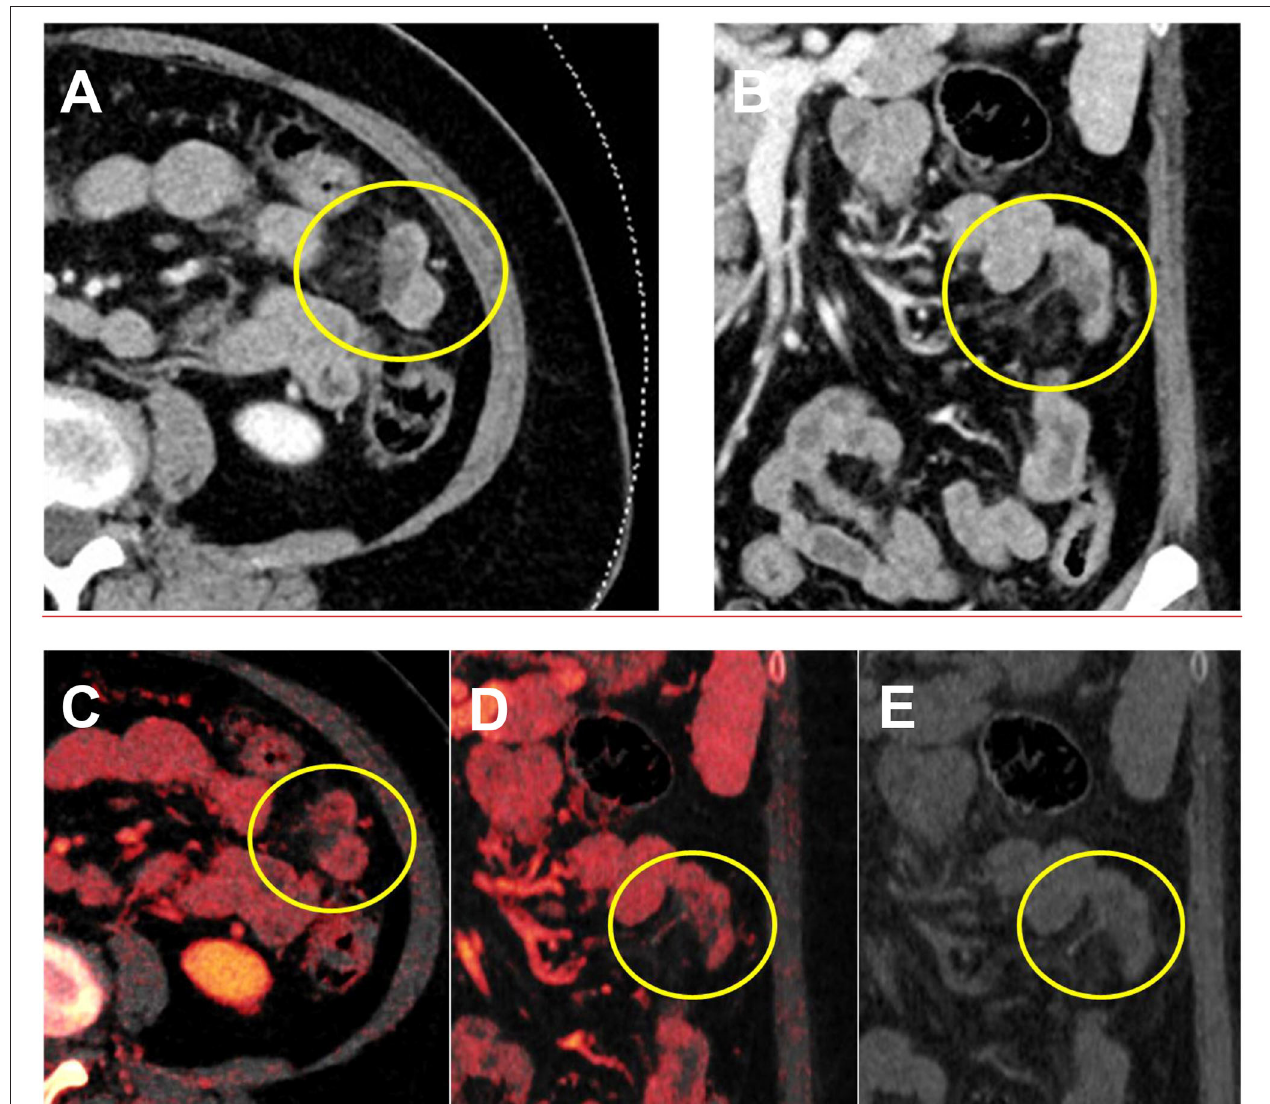
FIGURE 5 | A 17-year-old male patient presenting with pain and vomiting after trauma during a basketball game. (A,B) Conventional CT demonstrates hypodensity in the bowel wall. (C,D) No internal iodine enhancement and uptake were confirmed using the iodine overlay map, confirming bowel wall hematoma. (E) On the virtual non-contrast image, the bowel wall remains